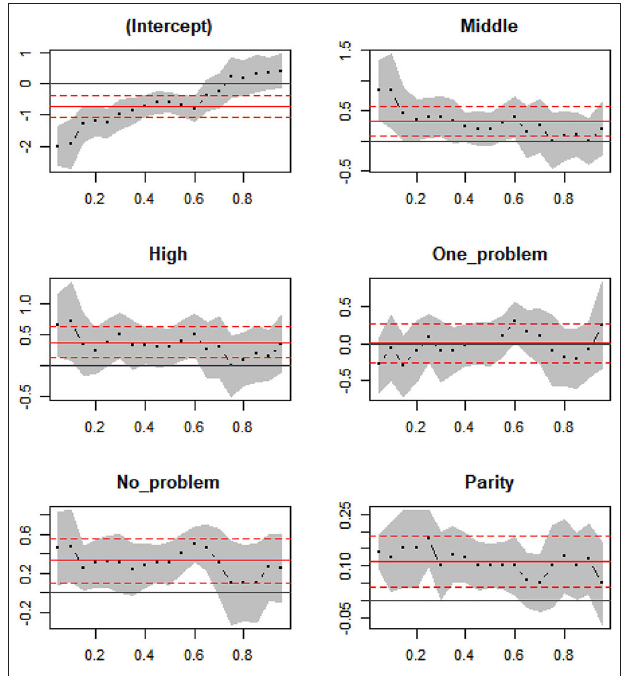
FIGURE 4 | Estimate coefficients for birth weight with 95 %